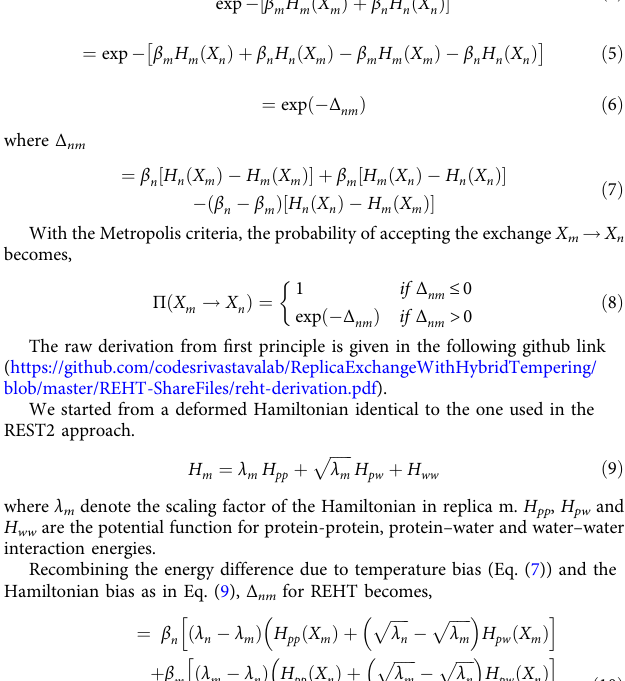
Theoretical SAXS analysis . Theoretical SAXS pro fi le for the HIS-5 ensemble was predicted using CRYSOL-2.8.4 68 that calculates orientationally averaged scattering pattern using multipole expansion from atomic coordinates while considering the solvation shell using spherical harmonics. The predicted value is compared against the experimental form factor of His-5 obtained at neutral pH from Skepo et al. 43 . Theoretical analysis of chemical shifts . The backbone chemical shifts of His-5 and RFA-H atomic coordinates were calculated using SPARTA + (v2.90) 69 , that works based on arti fi cial neural network. To validate our simulation, the predicted shifts were compared against the experimental NMR chemical shifts as obtained from BMRB database (https://bmrb.io) entry 17615 52 and from literature 46 . Structural analysis . Other structural parameters such as root mean squared deviation (RMSD), radius of gyration (Rg) and backbone dihedral angles were analyzed using the respective Gromacs utilities. Analysis of protein secondary structures was performed using DSSP tool (v2.2.1). VMD was used for visualizing the trajectory and rendering of protein cartoon